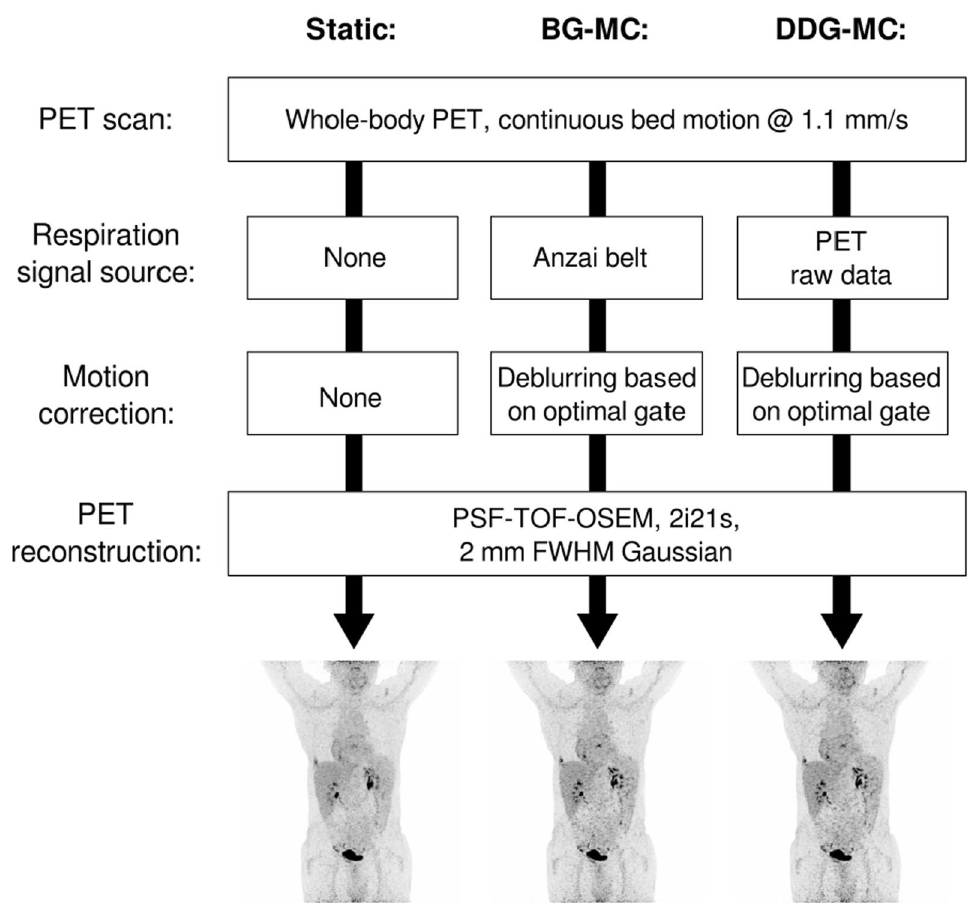
Fig. 1 Reconstruction workflow used for the three PET images (“static,” “BG-MC” and “DDG-MC”) performed within this